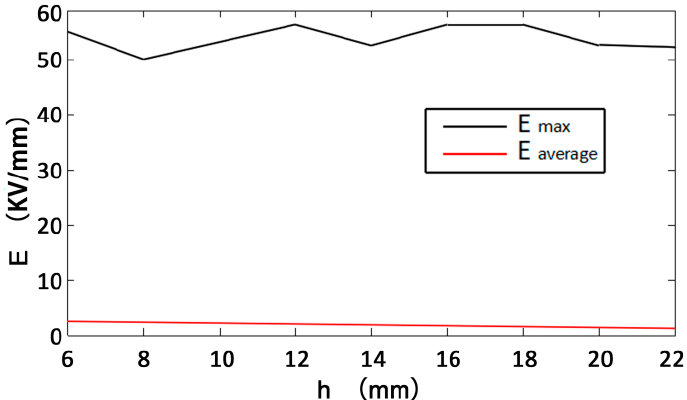
Figure 16. Variation of rock field strength with rock thickness.